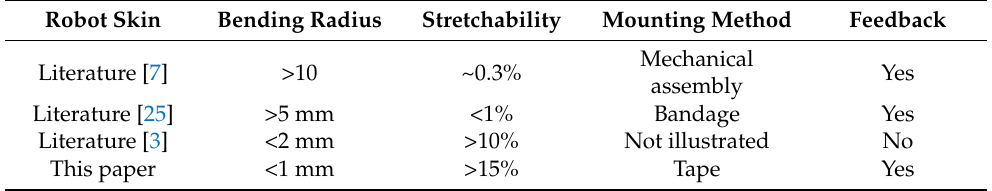
Table 1. Performances of robotic electronic skin